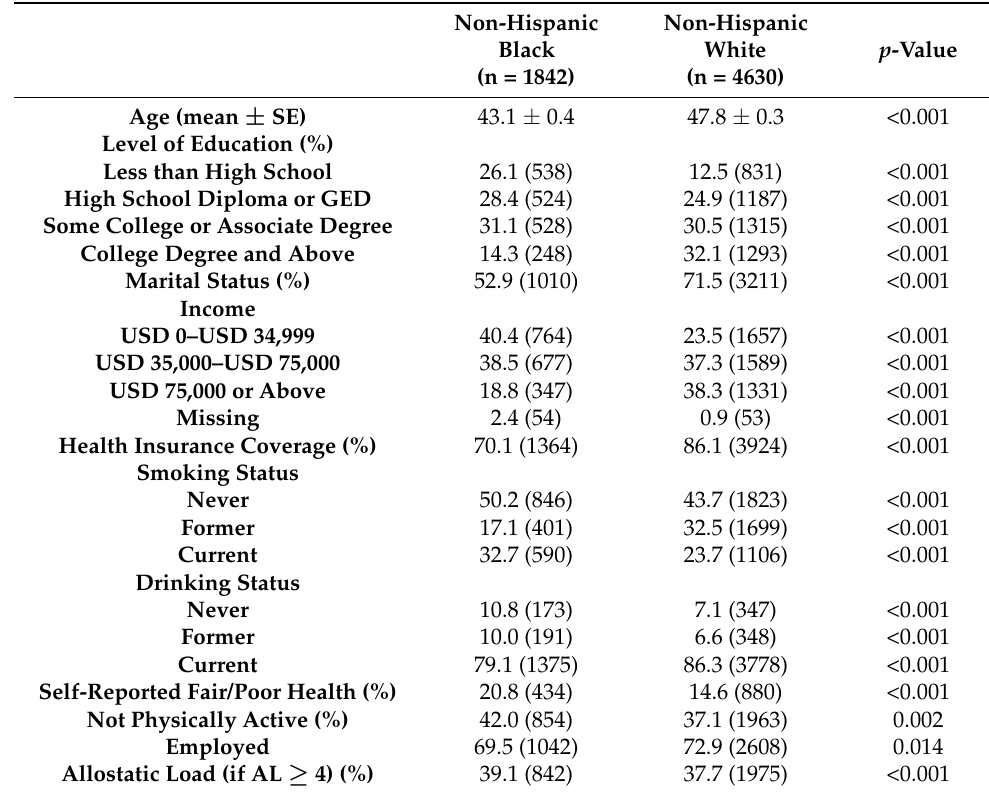
Table 1. Distribution of select characteristics of non-Hispanic Black and non-Hispanic White men using 1999–2016